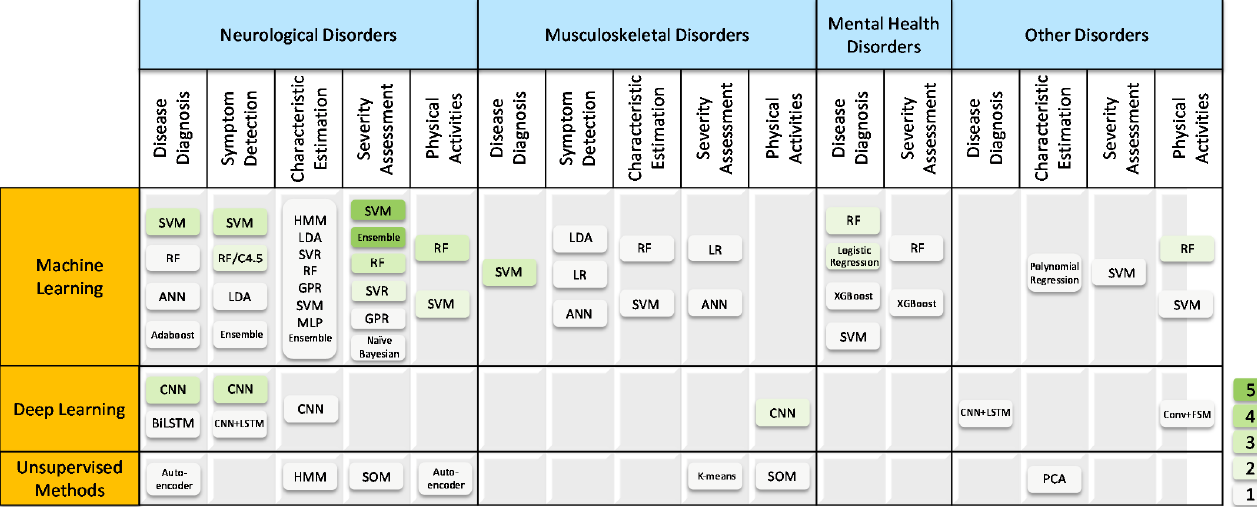
Figure 6. A summary of the reviewed works. The color of each bubble represents the number of reviewed works covering a given data processing method (row) and detailed application scenarios (column).